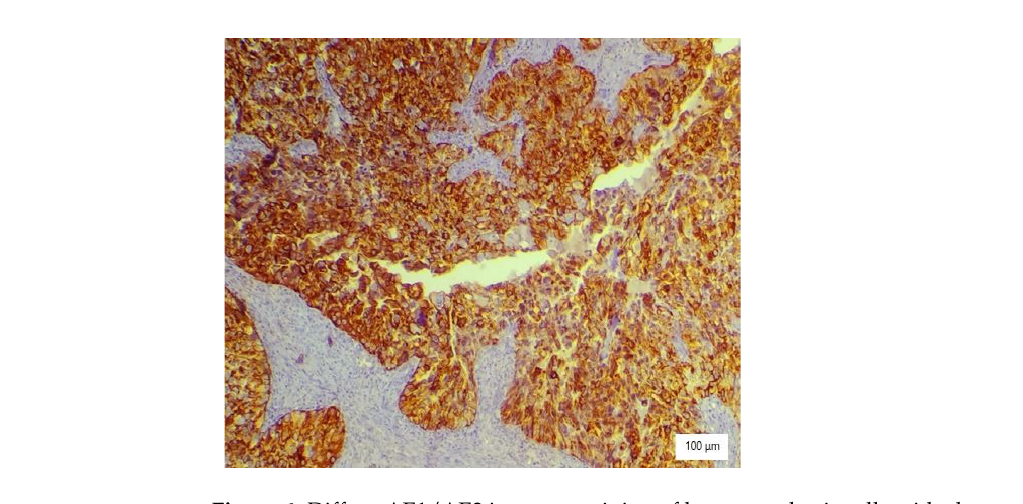
Figure 6. Diffuse AE1/AE3 immunostaining of large neoplastic cells with clear cytoplasm (×200).